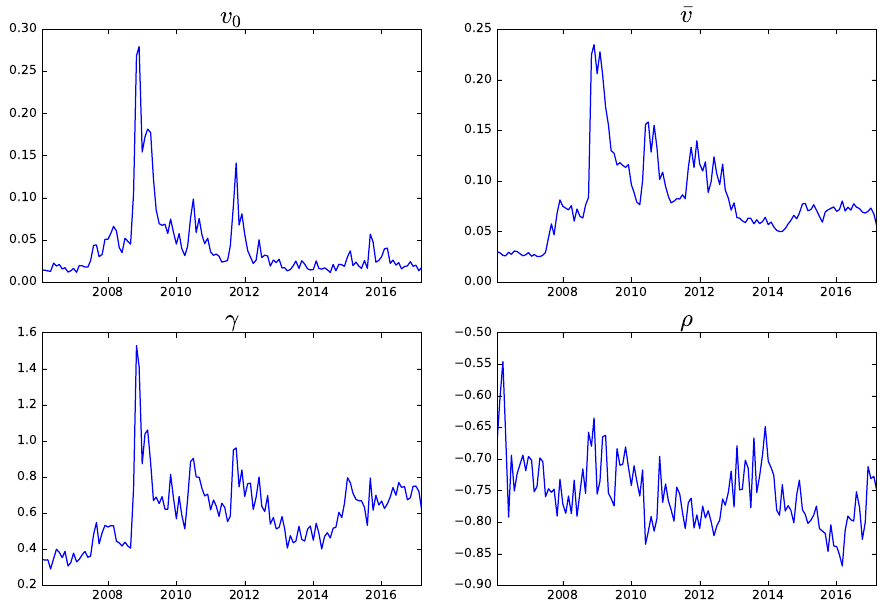
Figure 1. Evolution of the Heston parameters over